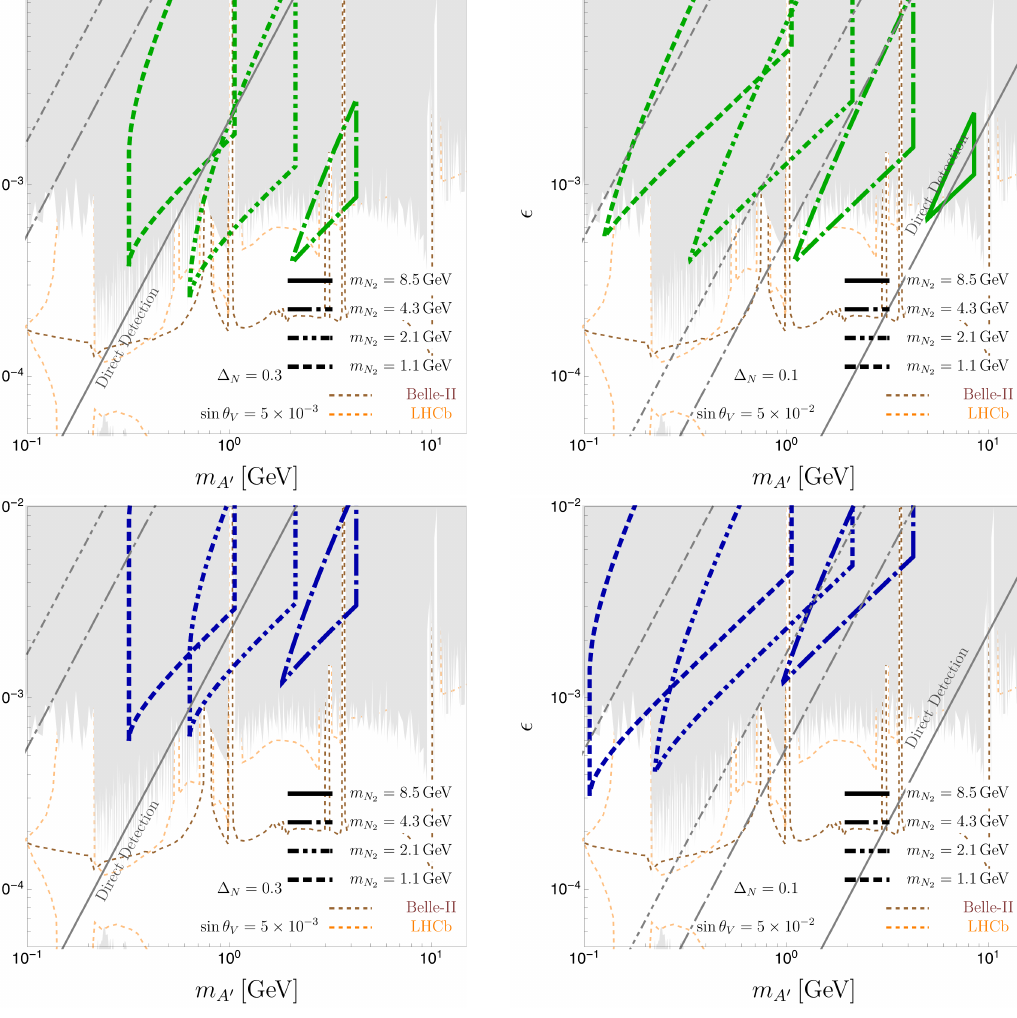
= 8 . 5 , 4 . 3 , 2 . 1 , Figure 4 . Dark nucleon searches at the LHC lifetime frontier on (cid:15) - m A 0 plane: m N 2 and 1 . 1 GeV from right to left that correspond to n = 1 , 2 , 4 , and 8 , the mixing angle g 0 sin θ = 5 × 10 − 3 (left) and sin θ = 5 × 10 − 2 (right), ∆ = 0 . 1 (left) and ∆ = 0 . 3 (right). The V V N N U(1) coupling to be α 0 = 0 . 05 , 0 . 03 , 0 . 01 , and 7 × 10 − 3 from right to left. The top (bottom) panels D show the future sensitivity at MATHUSLA (FASER): the area inside the lines can be explored by the experiments. The gray shaded region is excluded by the existing constraints on visible dark photon decay: (top region) the prompt decay searches by BaBar [3, 8], KLOE [9, 80–82], and LHCb [126, 165]; (left-bottom region) the fixed-target experiments ν Cal [144, 145] and CHARM [141, 142]. The future sensitivity of Belle-II (LHCb) to visible dark photon decay is shown as brown (orange) dashed lines on middle parts of the panels [25, 27]. The gray diagonal lines shows the direct detection bound on the composite ADM, and the parameter space above the line is already excluded. The sensitivity of MATHUSLA and FASER sharply cut at the left side of sensitivity because the decay into the on-shell dark photon